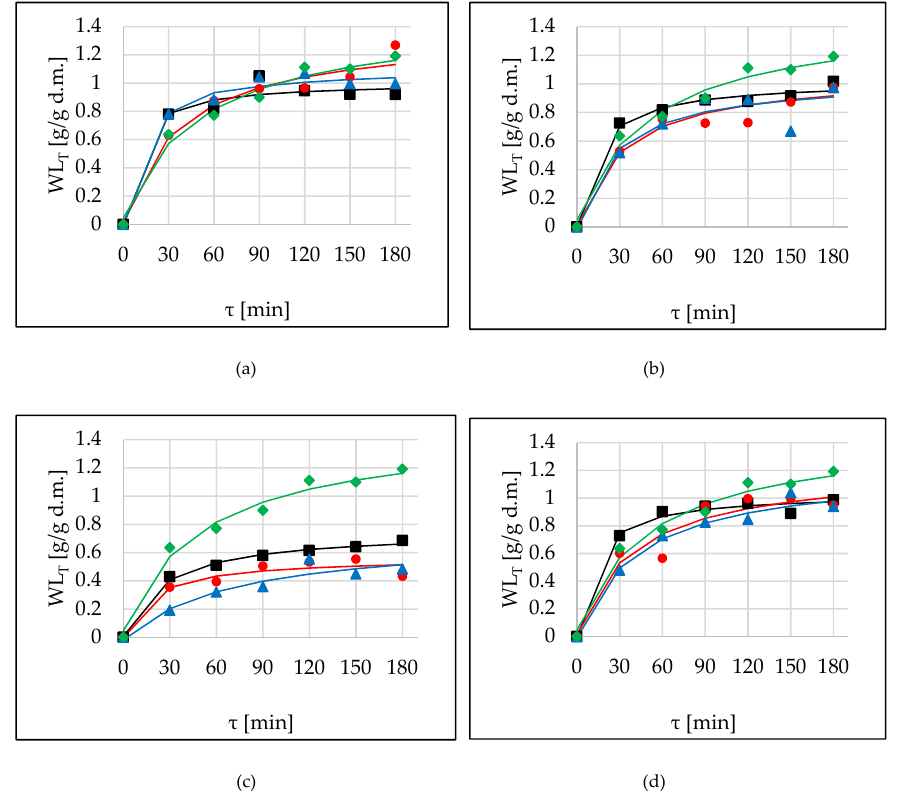
Figure 3. True water loss (WL T ) kinetics in several conditions (OD ( ■ ), OD+US ( ● ), OD+USi ( ▲ )) at 40 °C in different solutions: ( a ) erythritol, ( b ) xylitol, ( c ) maltitol, ( d ) DHA. Lines are the Peleg’s model. The green line ( ♦ ) is the kinetic reference (sucrose). Table 7. The influence of osmotic agents and pre-treatment time on true water loss during OD.